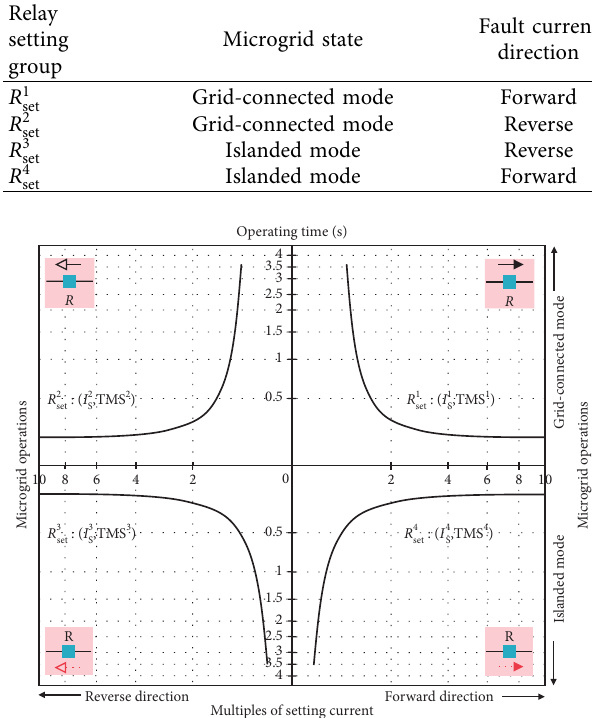
Figure 3: The proposed quaternary time-current curve for each